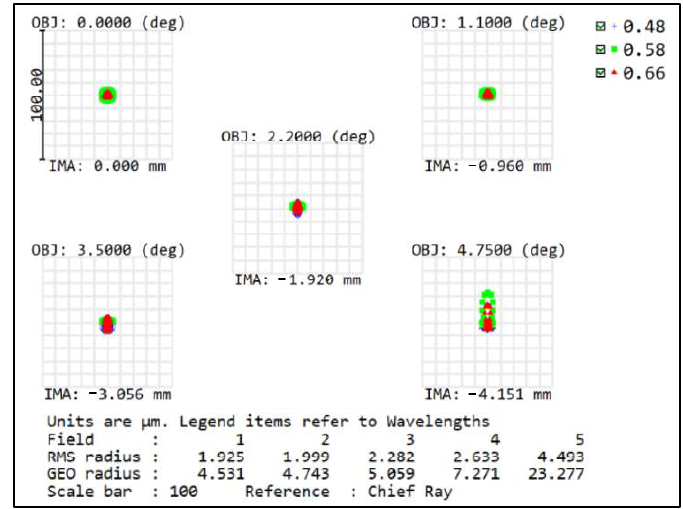
Figure 11. Spot diagram of the concentric multi-scale optical system.